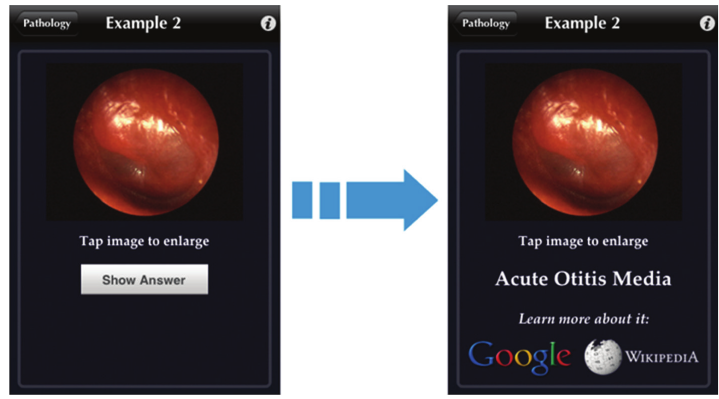
Figure 4: Interactive quizzes provide instantaneous feedback to the user.